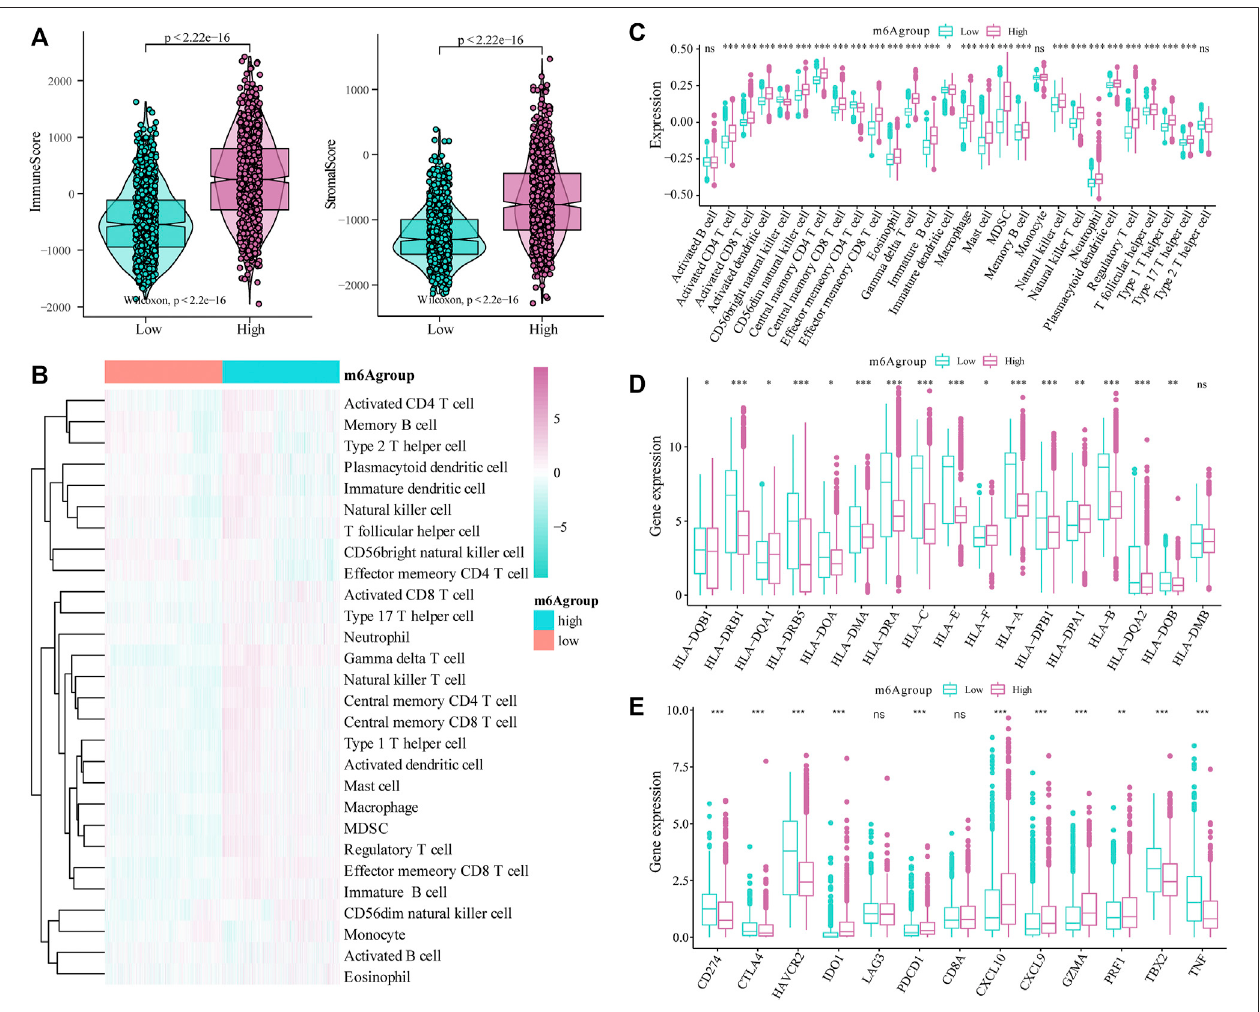
FIGURE 7 | Correlation of the m6A risk score with different immune cell in fi ltration. (A) Compared with the low expression group, the immune-related scores and stromal-related scores of patients in the high-risk group were signi fi cantly increased ( p < 0.001); (B) The overall immune in fi ltration level of glioma patients was analyzed basedonthessGSEAalgorithm; (C) Correlationanalysisshowsthattherearesigni fi cantdifferencesintheexpressionofmultipleimmunesubtypesinpatientsinthehigh andlowm6Agroups; (D) TherearedifferencesintheexpressionofmultipleHLAfamilygenesbetweenthehighandlowm6Agroups; (E) Therearealsodifferences in the expression levels of immune therapy-related target genes between the high and low m6A groups.